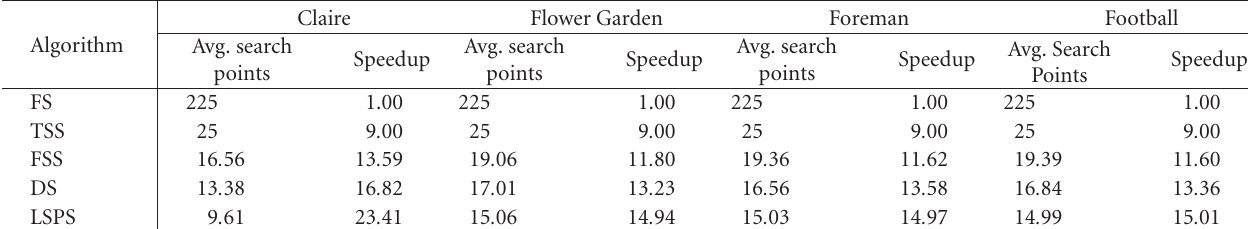
Table 2: Comparison between di ff erent BMAs in terms of the average search points per block.